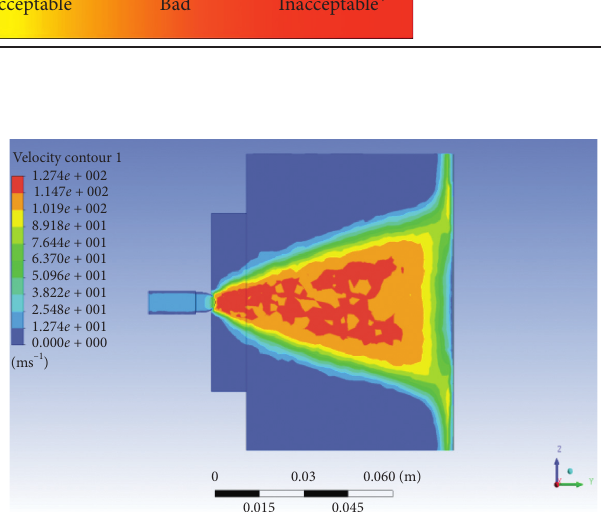
Figure 5: Water jet velocity nephogram with inlet pressure of 8